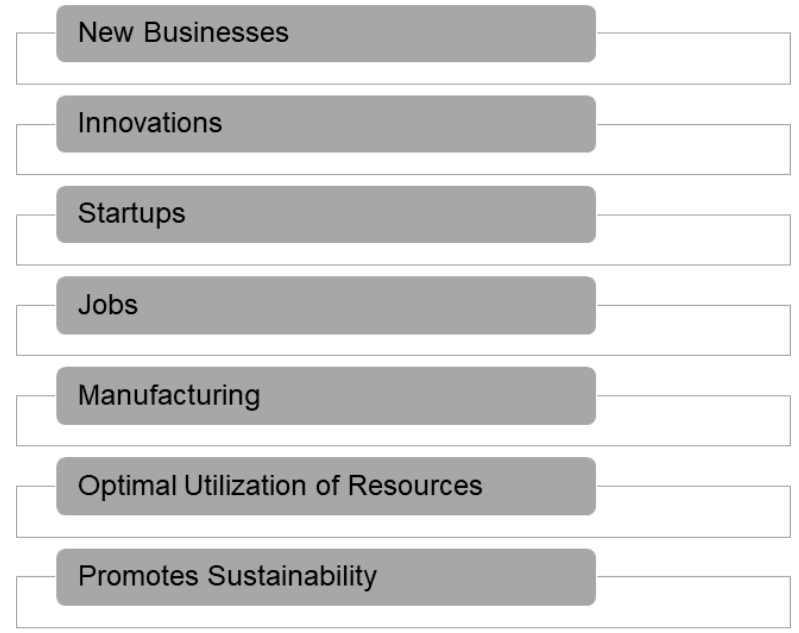
Figure 6. Opportunities of Smart City Initiatives.